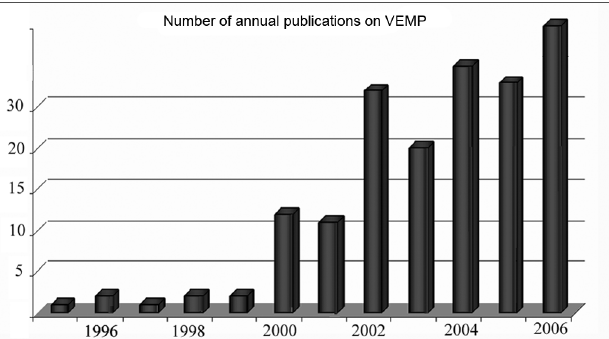
Figure 1. Annual publications on the Vestibular Evoked Myogenic Potential (VEMP) since 1995. Notice that as of the year 2000, there was a quick increase in the number of publications dealing with VEMP use. Source: www.pubmed.com.